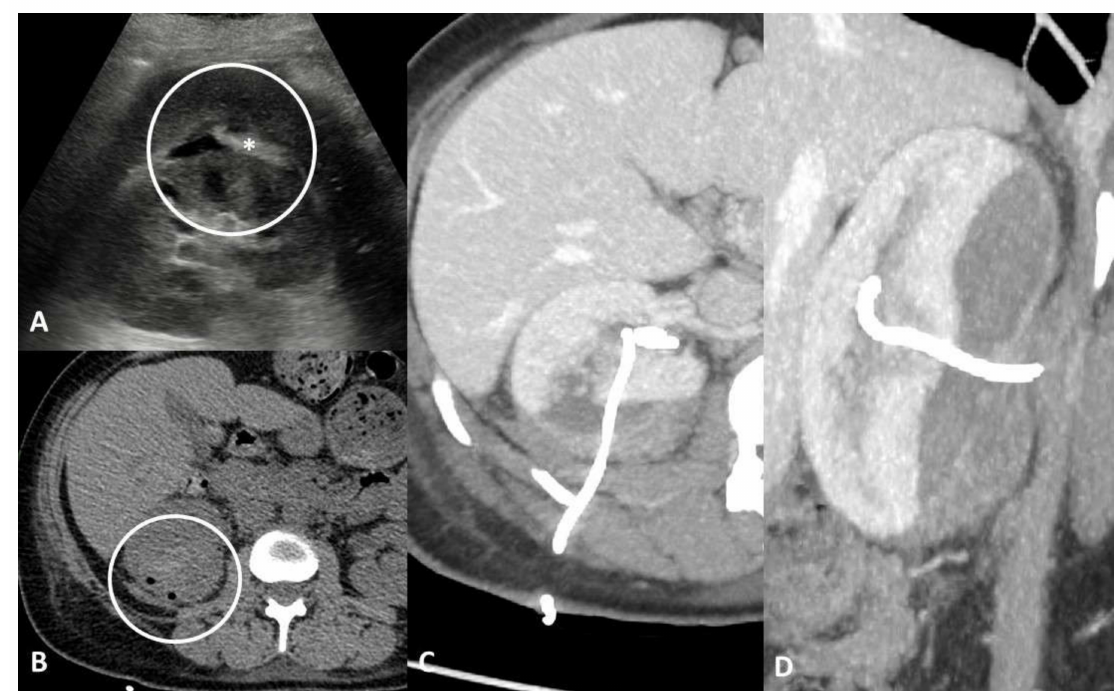
Figure 7. Parenchymal/tissue injury. Forty-one-year-old female with persistent haematuria after percutaneous nephrostomy placement. Axial ultrasound scan ( A ) shows hypoechoic collection of the right kidney with hyperechoic material inside (*). Non-enhanced CT scans ( B ) confirm the presence of a subcapsular hematic collection associated with a heterogeneous density area in the posterior renal parenchyma. Axial ( C ) and coronal ( D ) maximum intensity projection CT images show more clearly the large parenchymal laceration and the direct relationship with the nephrostomy tube, without signs of active